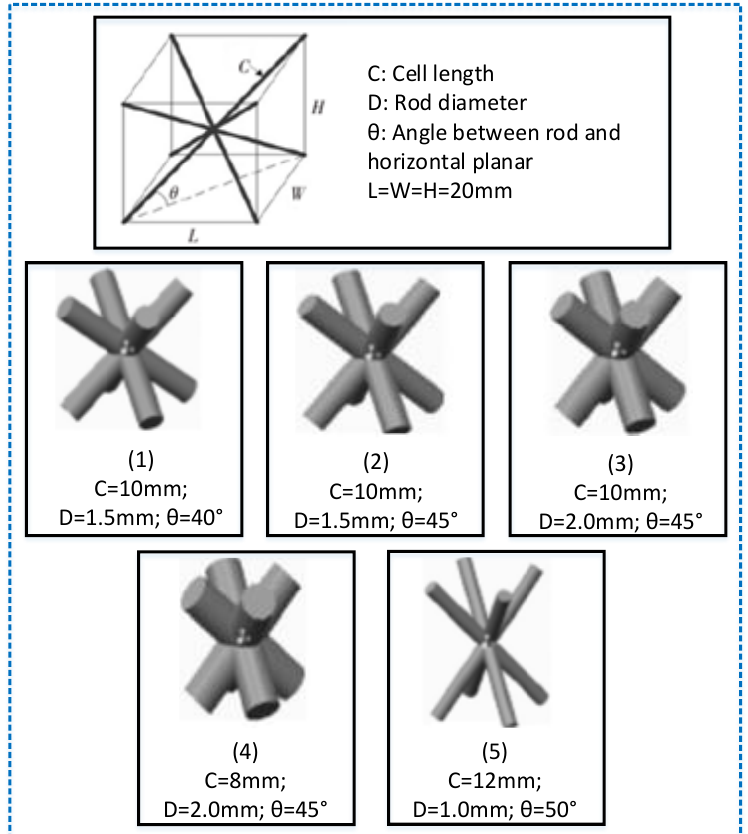
Figure 2. Comparison of different parameters for lattice structure .